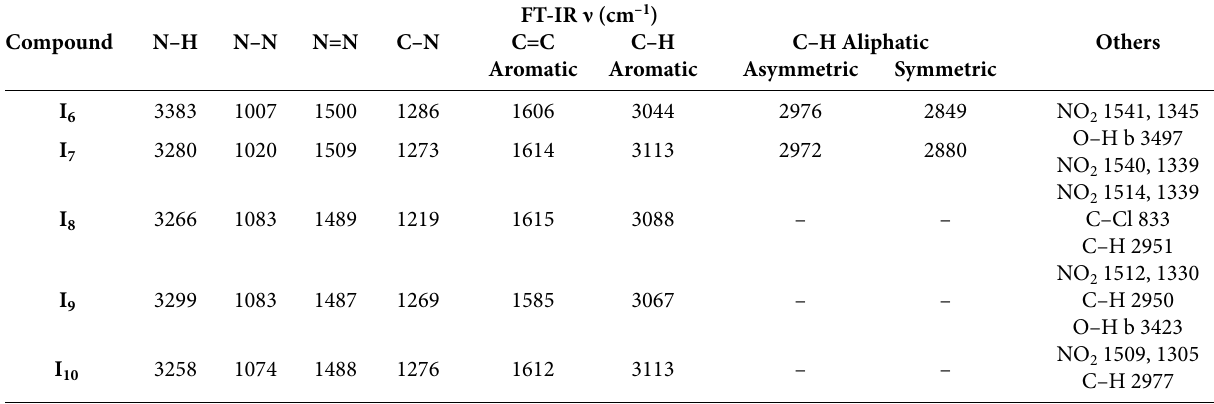
Table 4. FT-IR of tetrazole derivatives I 6 – I 10